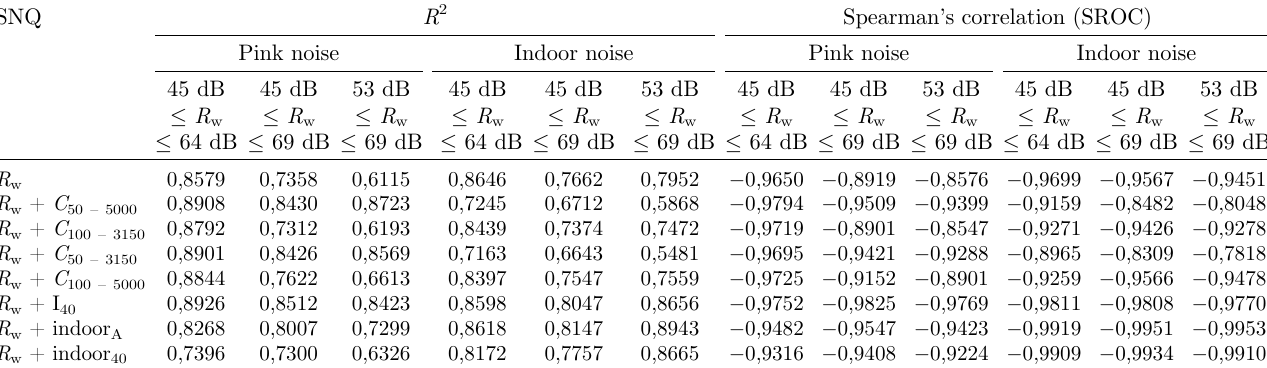
Table 3. R 2 SROC coef fi cients between SNQs and Loudness values based on pink noise and indoor noise, for wall categorized in different R w classes. SNQ R 2 Spearman ’ s correlation (SROC) Pink noise Indoor noise Pink noise Indoor